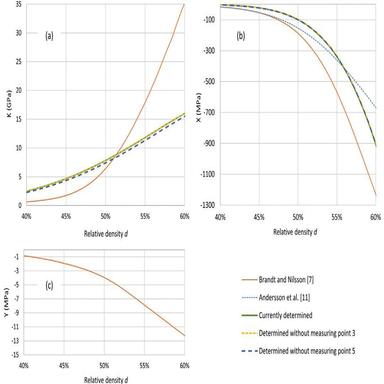
(a) Bulk modulus K(d) currently determined and compared with corresponding curves from Brandt and Nilsson . (b) Hydrostatic failure curve X(d) currently determined and compared with corresponding curves from Brandt and Nilsson and Andersson et al.. (c) Uniaxial yield stress Y(d) according to Brandt and Nilsson .